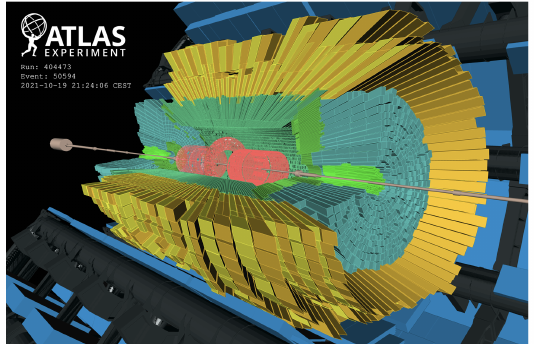
Figure 8. Illustration of a data event recorded by the ATLAS detector from the LHC beam splashes during the LHC pilot run in October 2021. The image shows a cutout view of the ATLAS detector for an event where the proton test beam from the LHC is coming into the ATLAS detector from the left of the picture (which shows the A-Side of the detector) and travelling to the right (showing the C-Side). The red stripes are used to visualise the particle-matter interactions in the inner layers, the green boxes show the energy deposits in the LAr calorimeters, the yellow boxes visualise energy deposits in the TileCal hadronic calorimeter and the blue boxes surrounding the central part of the image are part of the ATLAS muon spectrometer, shown here for context.